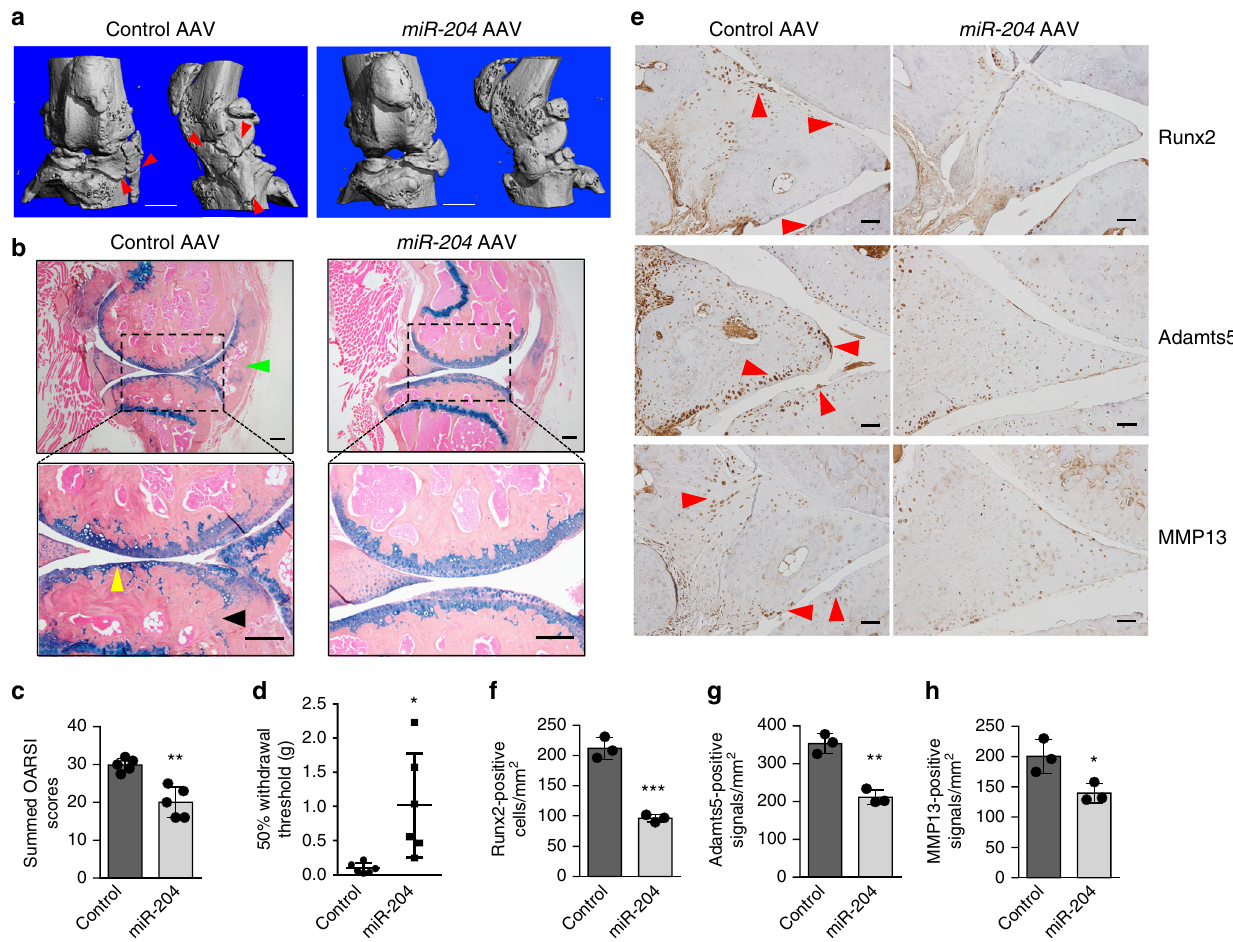
Fig. 6 Intraarticular injections of AAV5-miR-204 alleviates surgically induced OA phenotype. a Representative μ CT images of osteoarthritic joints in 9-month-old C57BL/6 mice receiving AAV5-GFP or AAV5-miR-204 injection at the age of 3 months. Red arrowheads, osteophytes. n = 5. Scale bar, 1 mm. b Representative histology images of osteoarthritic joints in 9-month-old mice receiving AAV injection at the age of 3 months. Yellow arrowheads, articular cartilage degradation; green arrowhead, synovial hyperplasia; black arrowhead, subchondral sclerosis. n = 5. Scale bars, 200 μ m. c Analysis using OARSI scoring system was performed to evaluate knee joint AC destruction in mice receiving AAV5-GFP (control) or AAV5-miR-204 injection. n = 5. Mann − Whitney test. d Intraarticular injection of AAV5-miR-204 reduces pain sensitivity induced by OA. The von Frey test was performed in 9-month-old mice receiving AAV injection at the age of 3 months. n = 6. e IHC results of Runx2, Adamts5, and MMP13 expression in osteoarthritic joints receiving